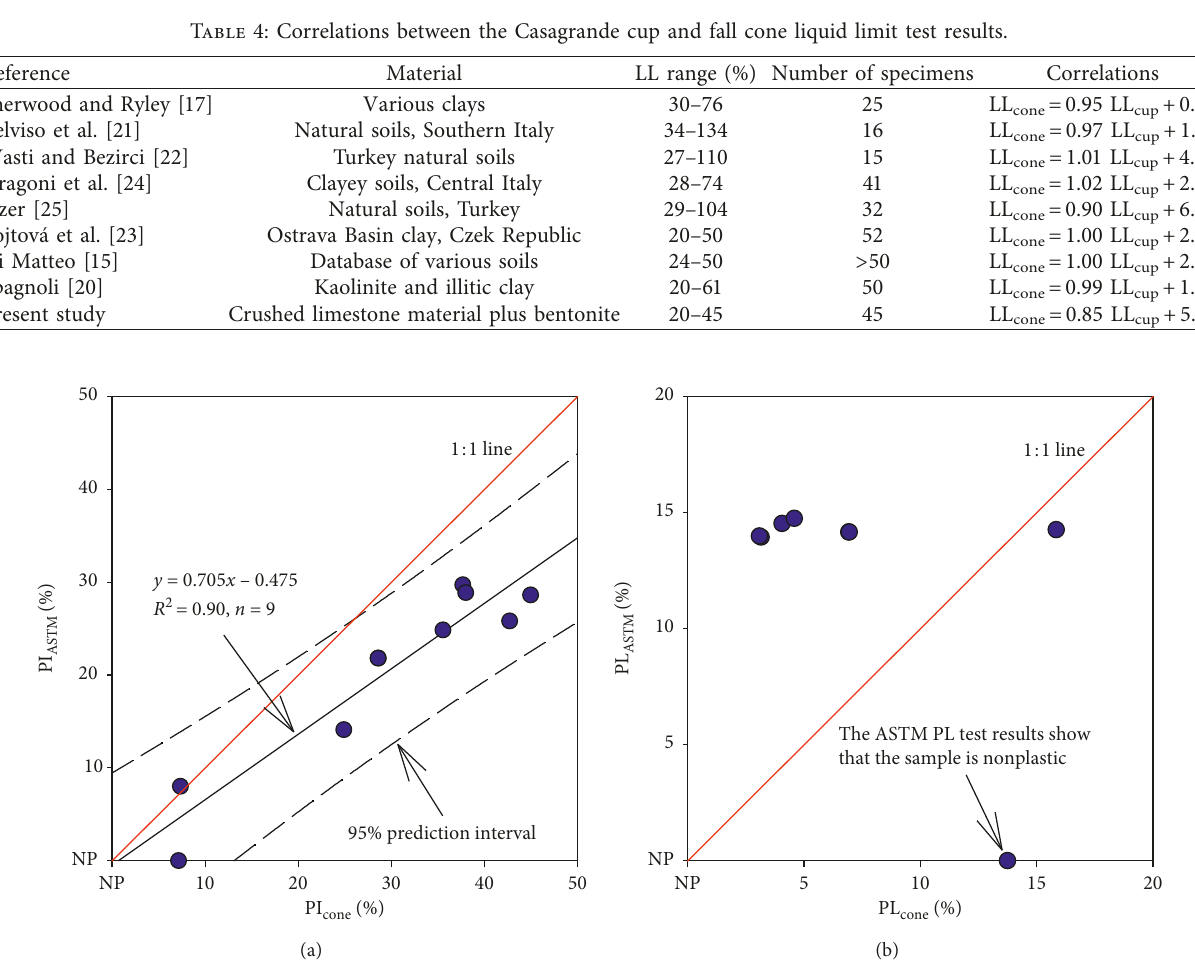
Figure 5: The (a) PI and (b) PL values determined using the fall cone and ASTM standardized